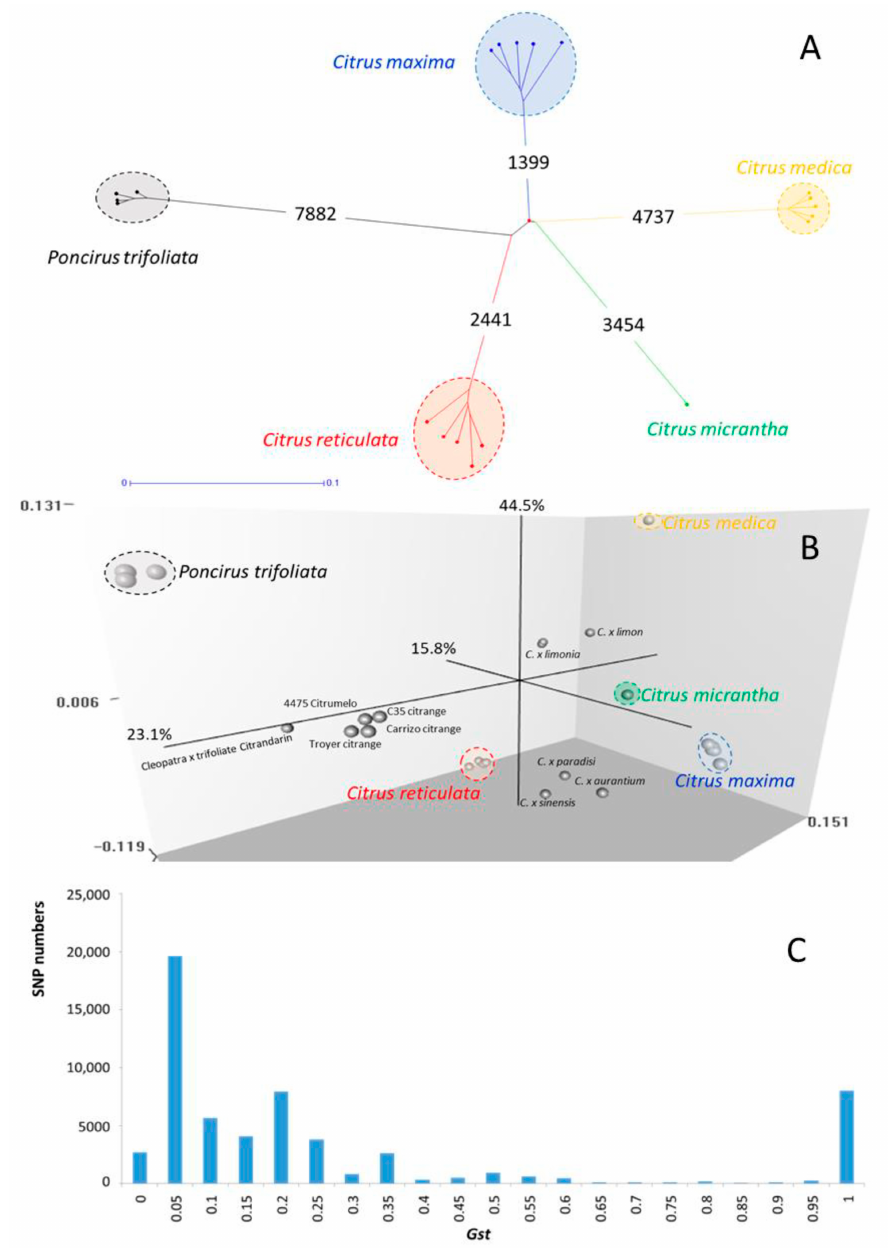
Figure 3. Organization of the genetic diversity revealed by GBS data. ( A ) Di ff erentiation between ancestor representatives. The number on the branches indicate the numbers of DSNPs for the di ff erent taxa. ( B ) Factorial analysis of the dissimilarity matrix with all accessions. ( C ) Distribution of G ST values considering Poncirus and Citrus genera as two